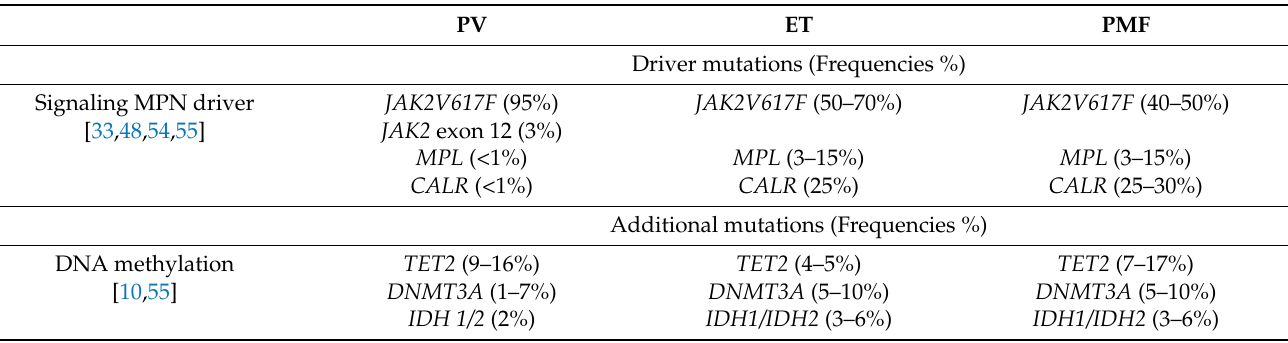
Table 2. Somatic mutations and frequencies in